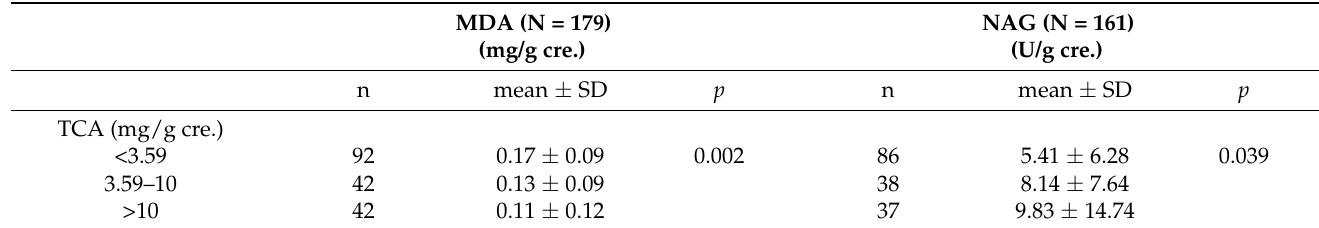
Table 3. Univariate analysis on urinary TCA affecting MDA and NAG levels.